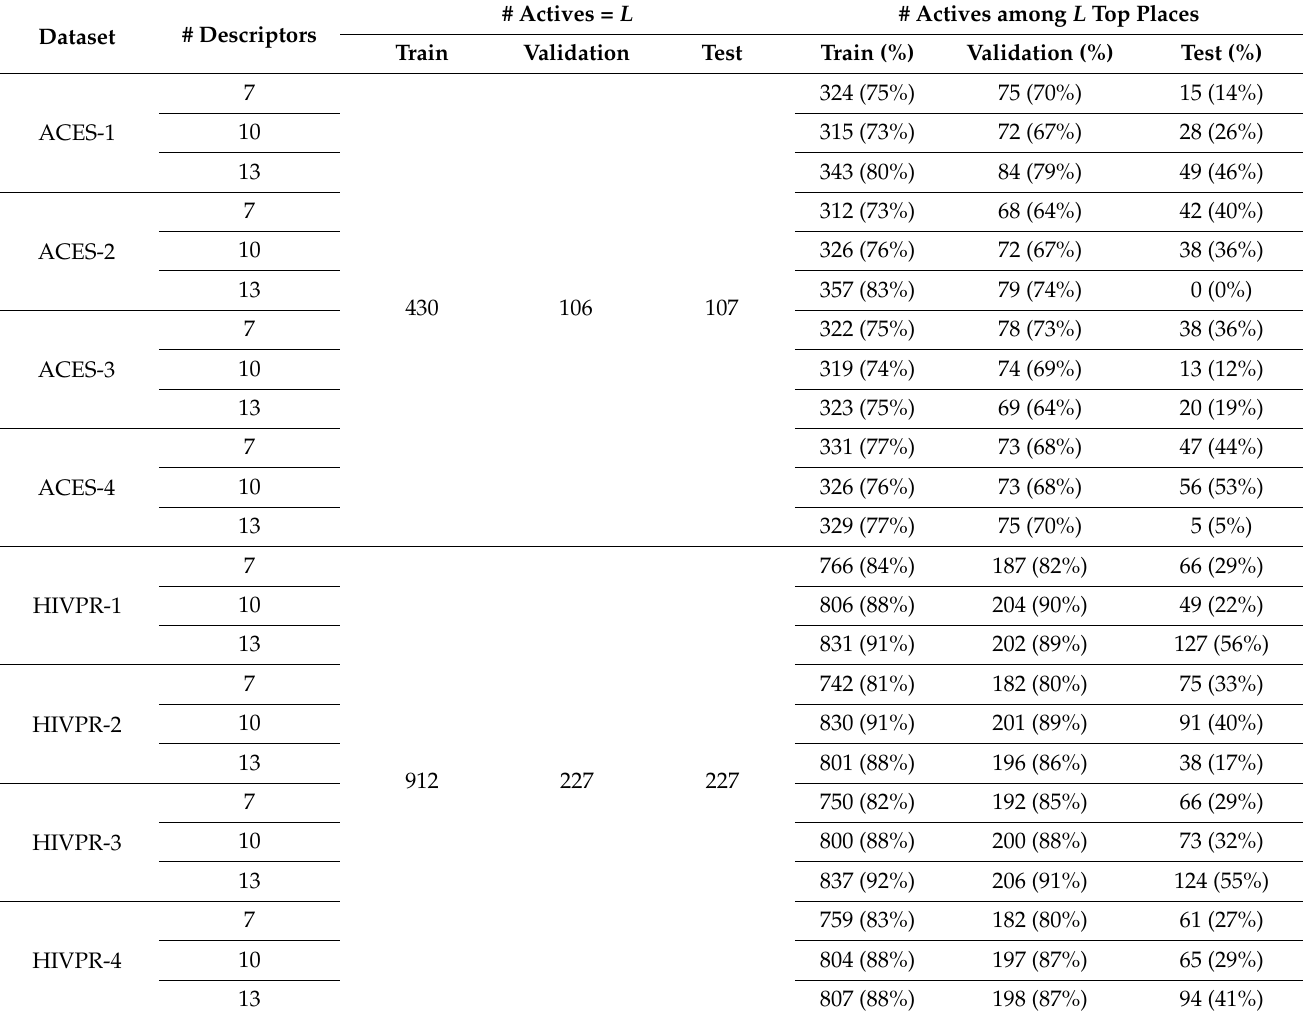
Table 1. EOA results obtained for all four subsets from all five datasets using 7, 10 and 13-descriptor models. Results are provided in terms on the number and percentage (based on the total number of actives) of active compounds appearing within the first L places of the list ranked according to the EOA